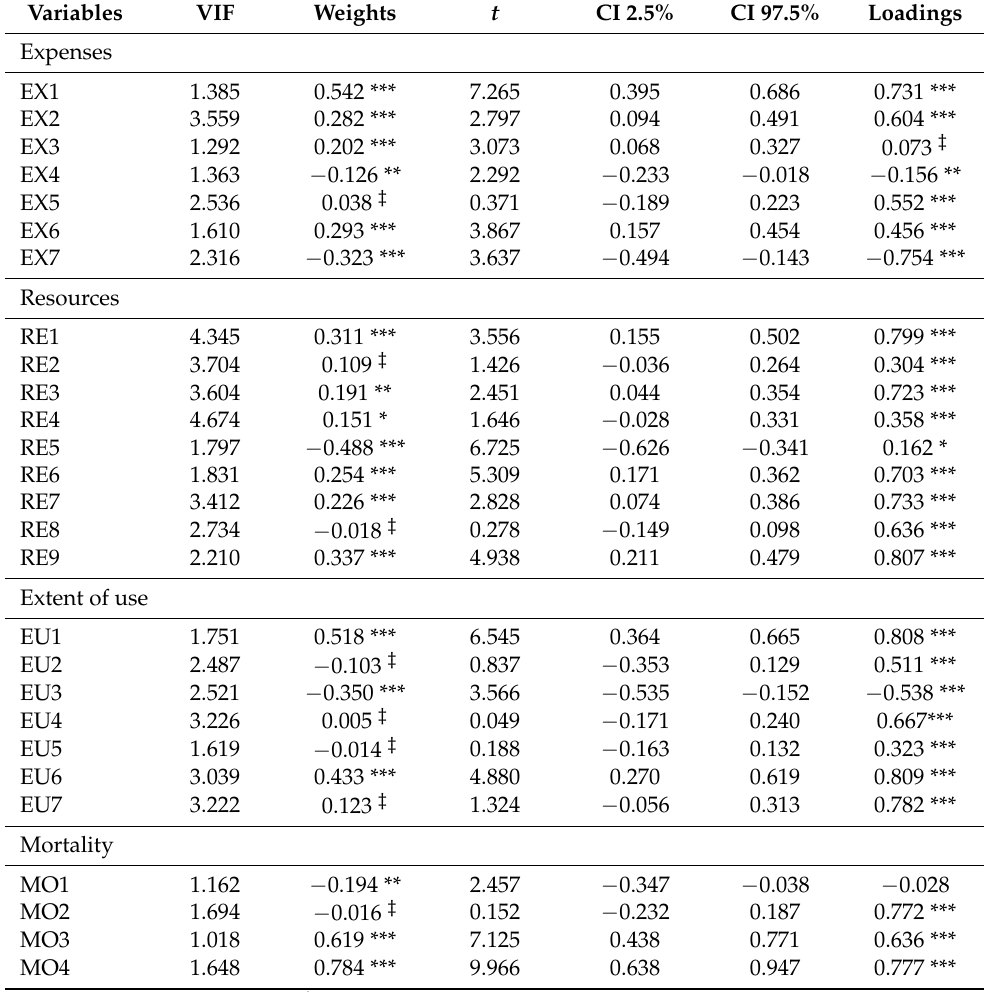
Table 4. Assessment of measurement model. Estimated constructs in mode B for